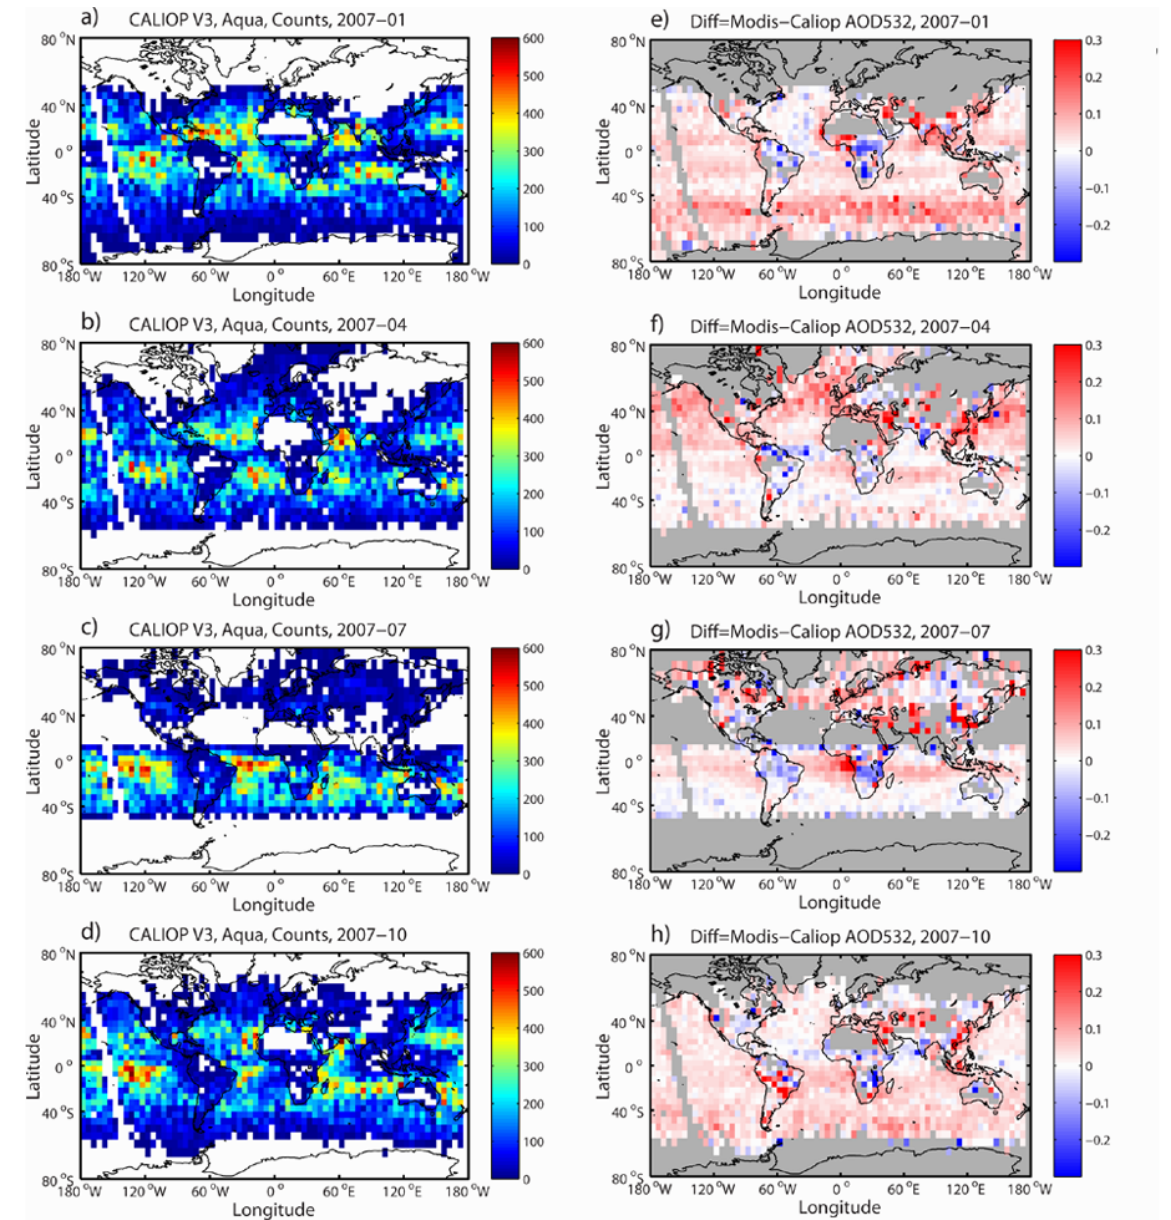
Fig. 8. (a) Global distribution of the number of instantaneously collocated MODIS versus CALIOP V3 AOD comparisons in 5 × 5 degree boxes for January 2007. (e) Global distribution of the mean difference between instantaneously collocated MODIS and CALIOP V3 AOD retrievals for January 2007. (b) – (d) same as (a) , but for April, July, and October of 2007. (f) – (h) same as (e) , but for April, July, and October of